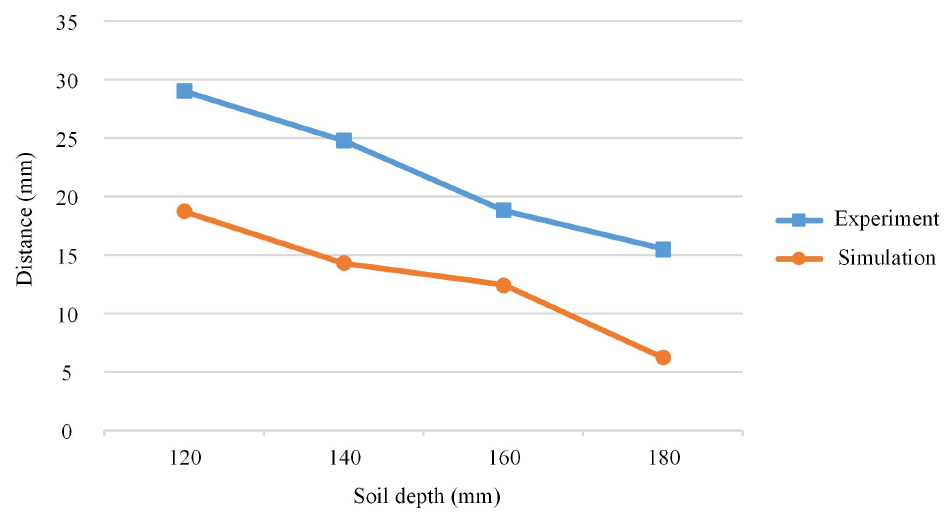
Figure 12. Comparison of simulation results and experiment results at different soil depths at 1.6